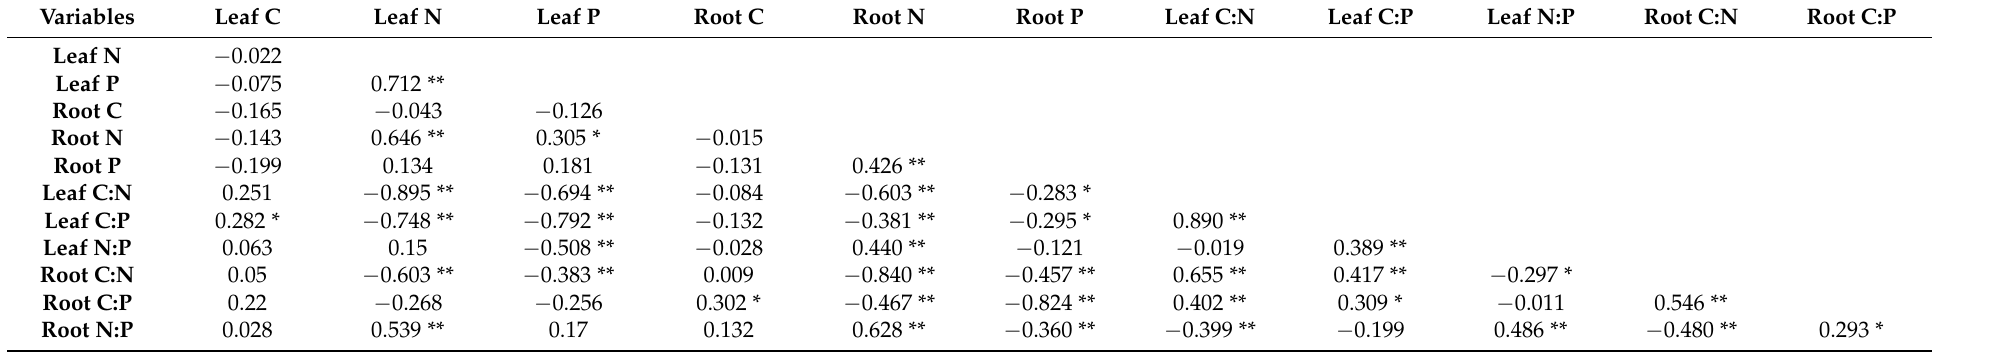
Table 4. Correlations and correlation probability between C, N, and P stoichiometry traits in karst